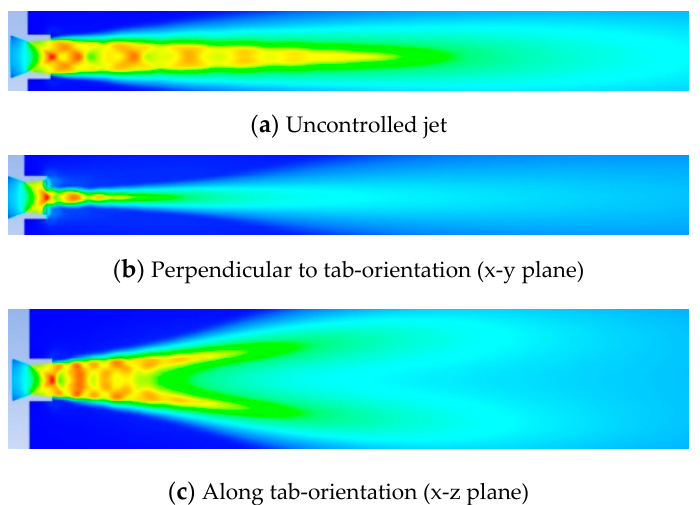
Figure 25. Mach contours of uncontrolled and controlled jets at NPR 5 (overexpansion).